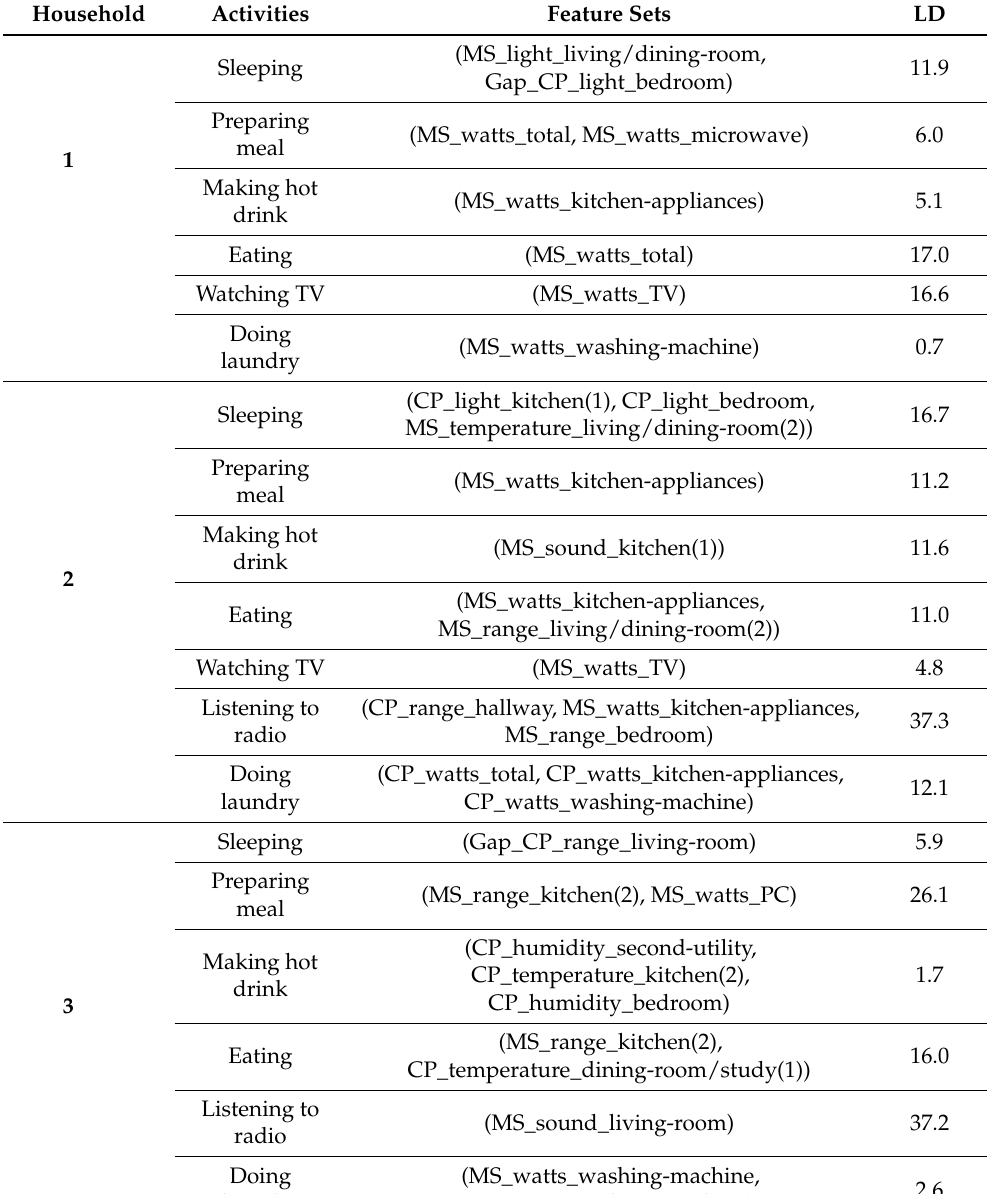
Table 7. Feature sets achieve best agreement with respect to the seven types of